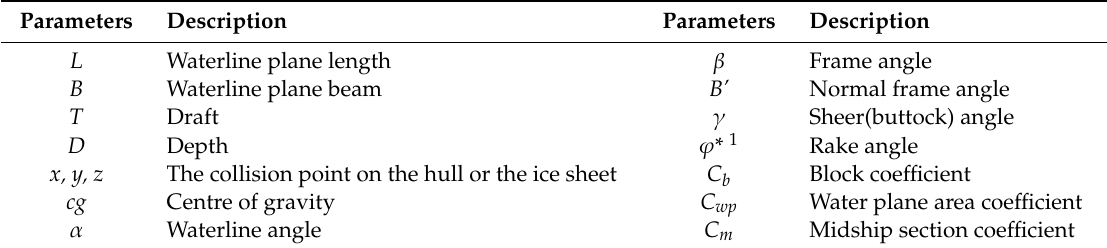
Table 1. Ship parameters.